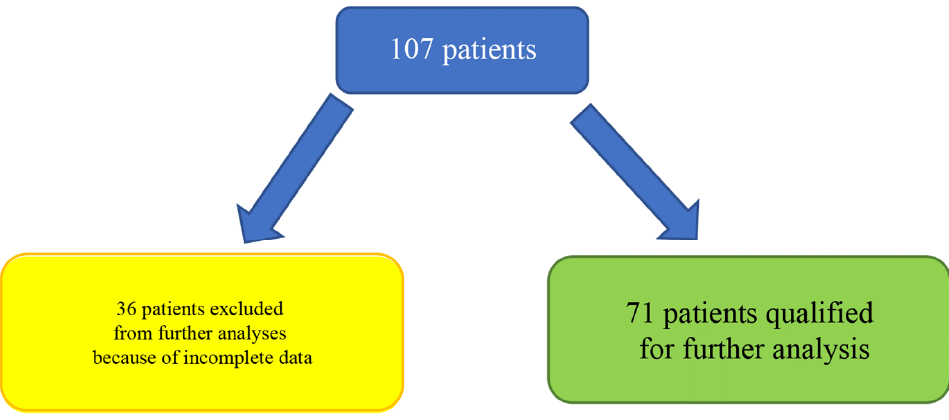
Figure 2. Flow chart describing qualification of patients to all parts of the